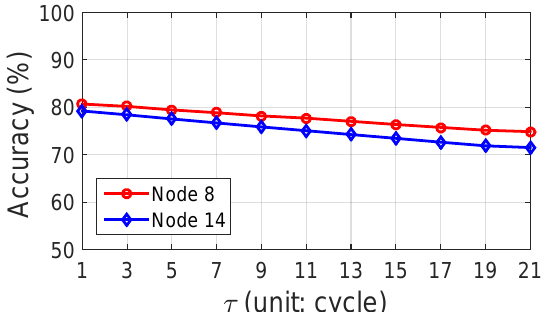
Figure 6. The accuracy of node status prediction with the tidal